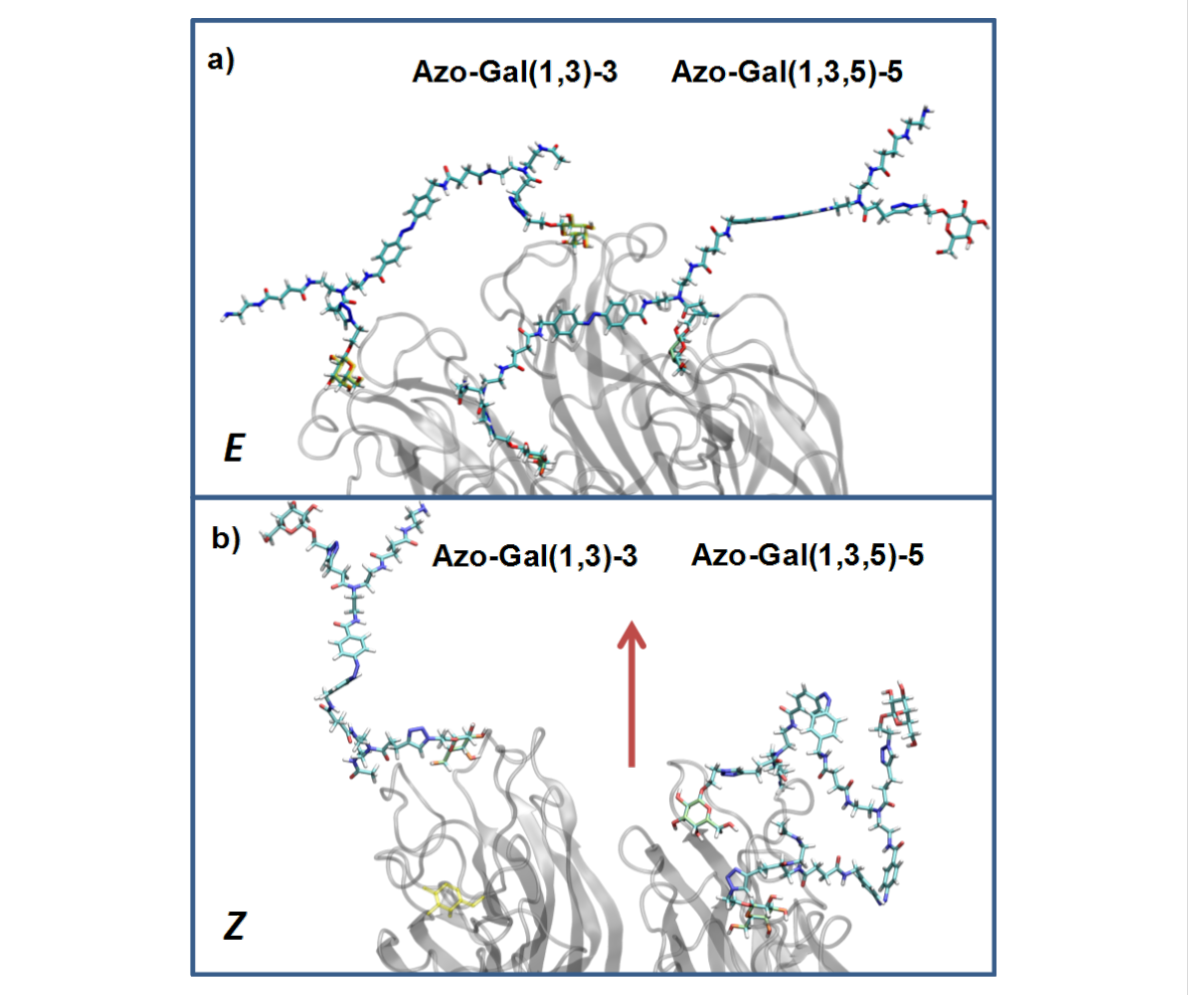
Figure 3: Structural models of Azo-Gal(1,3)-3 and Azo-Gal(1,3,5)-5 in (a) E - and (b) all- Z -configurations of the connecting azobenzene groups. The dimer is shown to the left, the trimer to the right. To facilitate the representation in (b), the whole complex has been rotated around the indicated in-plane axis (arrow). The PA-IL protein structure has been inferred from the Protein Data Bank (PDB code